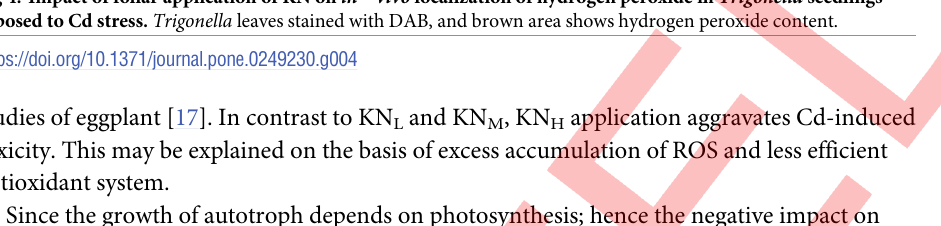
Fig 4. Impact of foliar application of KN on in—vivo localization of hydrogen peroxide in Trigonella seedlings exposed to Cd stress. Trigonella leaves stained with DAB, and brown area shows hydrogen peroxide content.